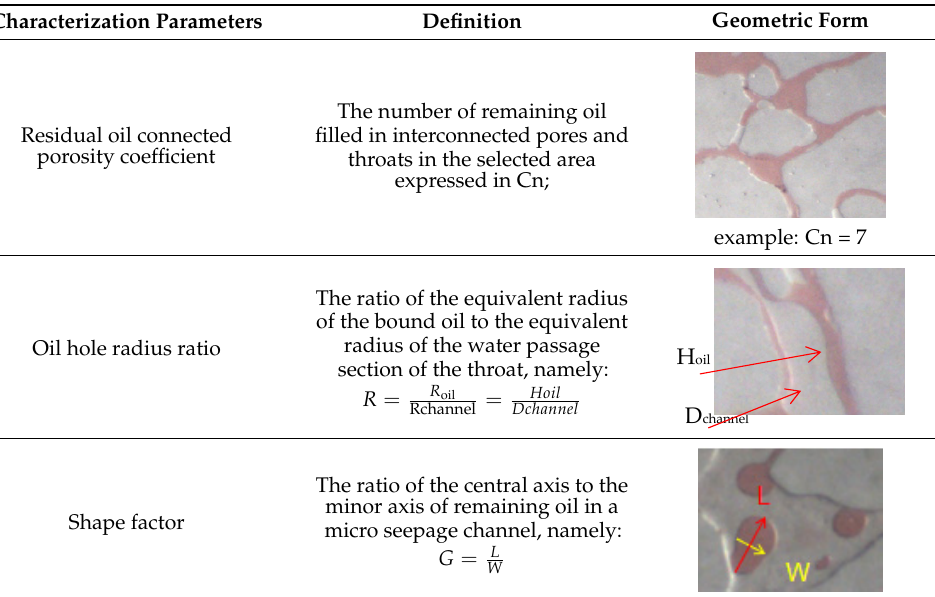
Table 1. Characterization parameters of micro remaining oil morphology.